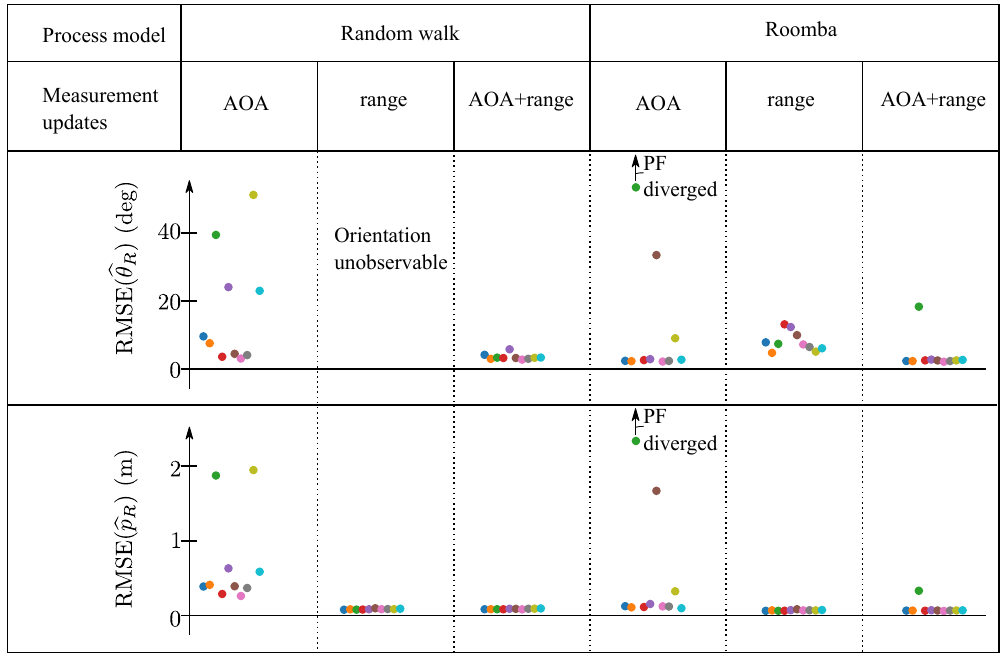
Figure A3. This figure compares the performance of particle filters having different process models and different measurement updates. The RMSE obtained for the ten different leave-one-out cross-validation evaluations are shown in different colors. The neural networks employed by the particle filters using AOA measurement updates were trained with datasets in which the AOA corresponding to a CIR measurement was provided by a motion capture